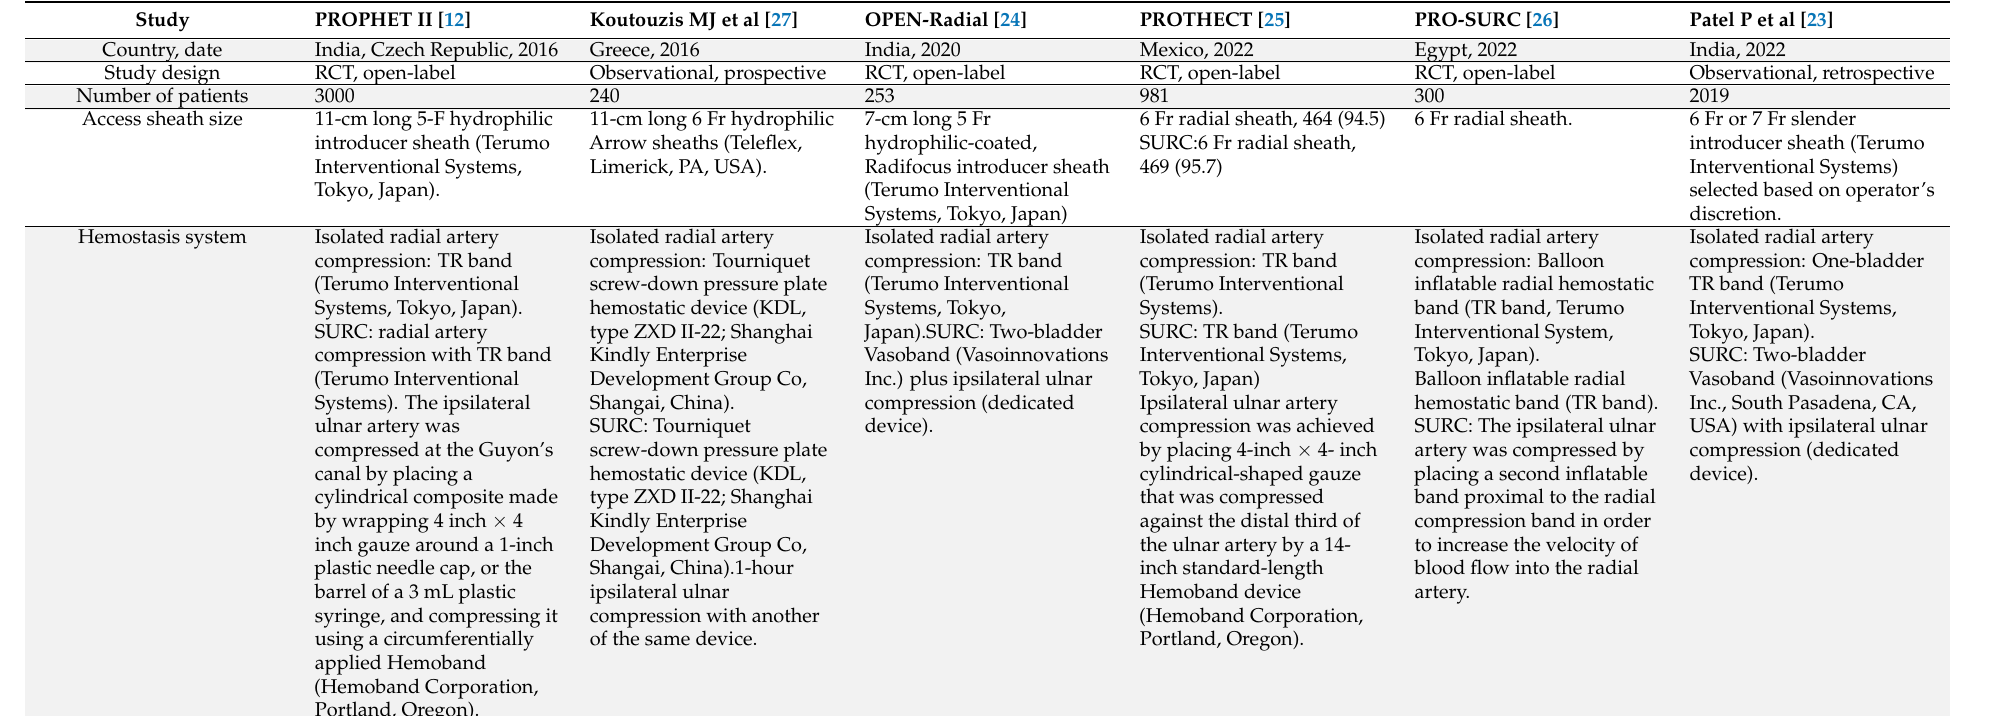
Table 1. Main trial and patient characteristics of included